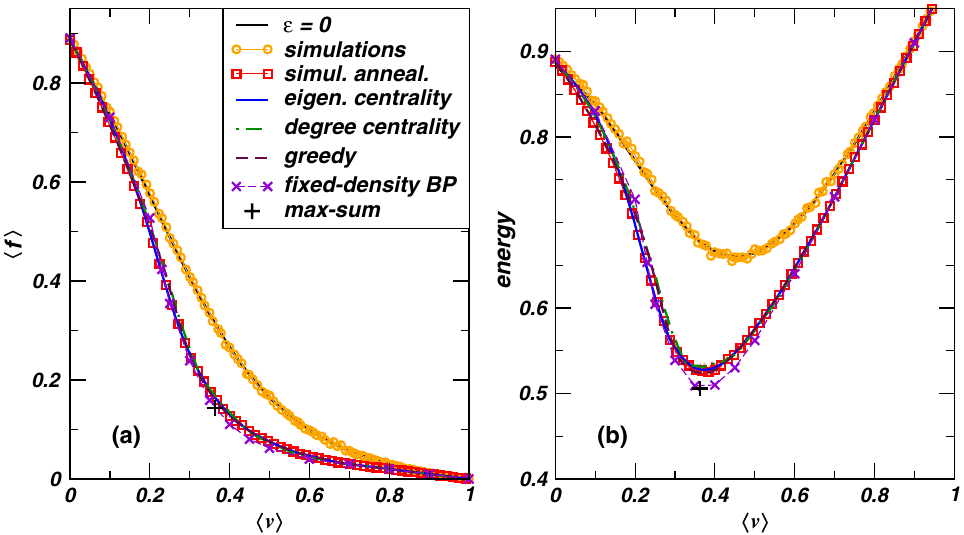
FIG. 12. Comparison between several immunization methods on a RRG with N ¼ 10 3 nodes and degree K ¼ 4 for the SIR model (with q ¼ 0 . 1 , p ¼ 0 . 5 ): (a) average fraction of infected nodes h f i vs average fraction of immunized nodes h v i ; (b) energy (for μ ¼ 1 . 0 ) vs average fraction of immunized nodes h v i . Reported results include the following: Simulated annealing (red squares), eigenvectors centrality (blue solid line), degree centrality (green dot-dashed line), greedy (maroon dashed line), and the best obtained solving fixed- density BP equations (violet crosses) and MS (black vertical cross). Random immunization is also reported (black line for the BP results with ϵ ¼ 0 and yellow circles for the results of direct stochastic